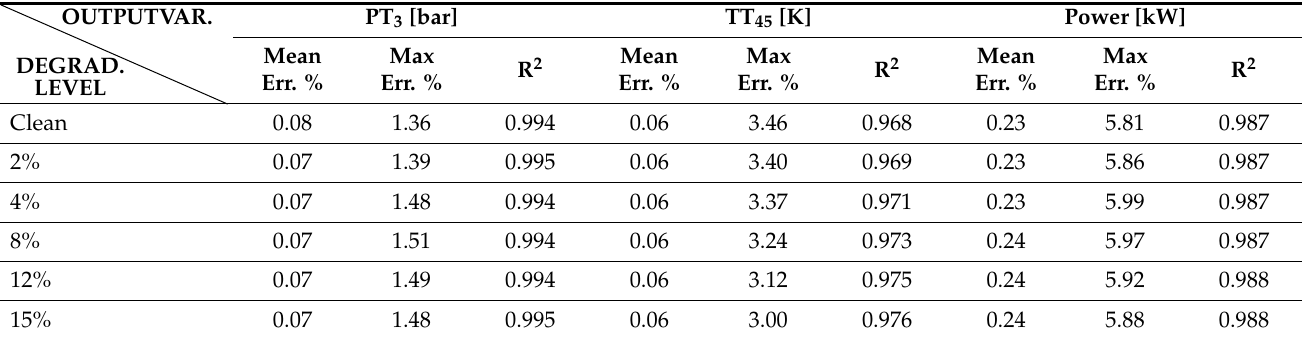
Table 5. Linear model validation.